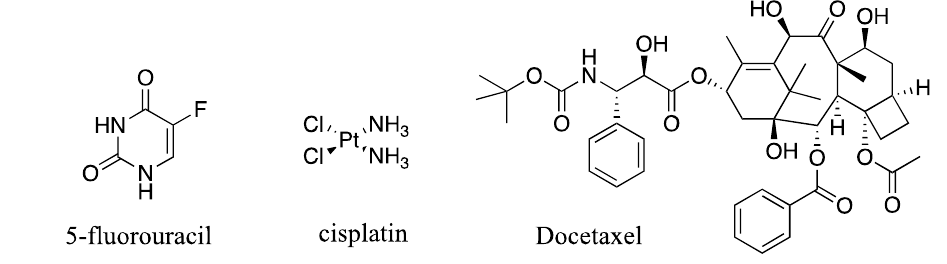
Figure 1. Most common chemotherapeutic agents for the treatment of OSCC.